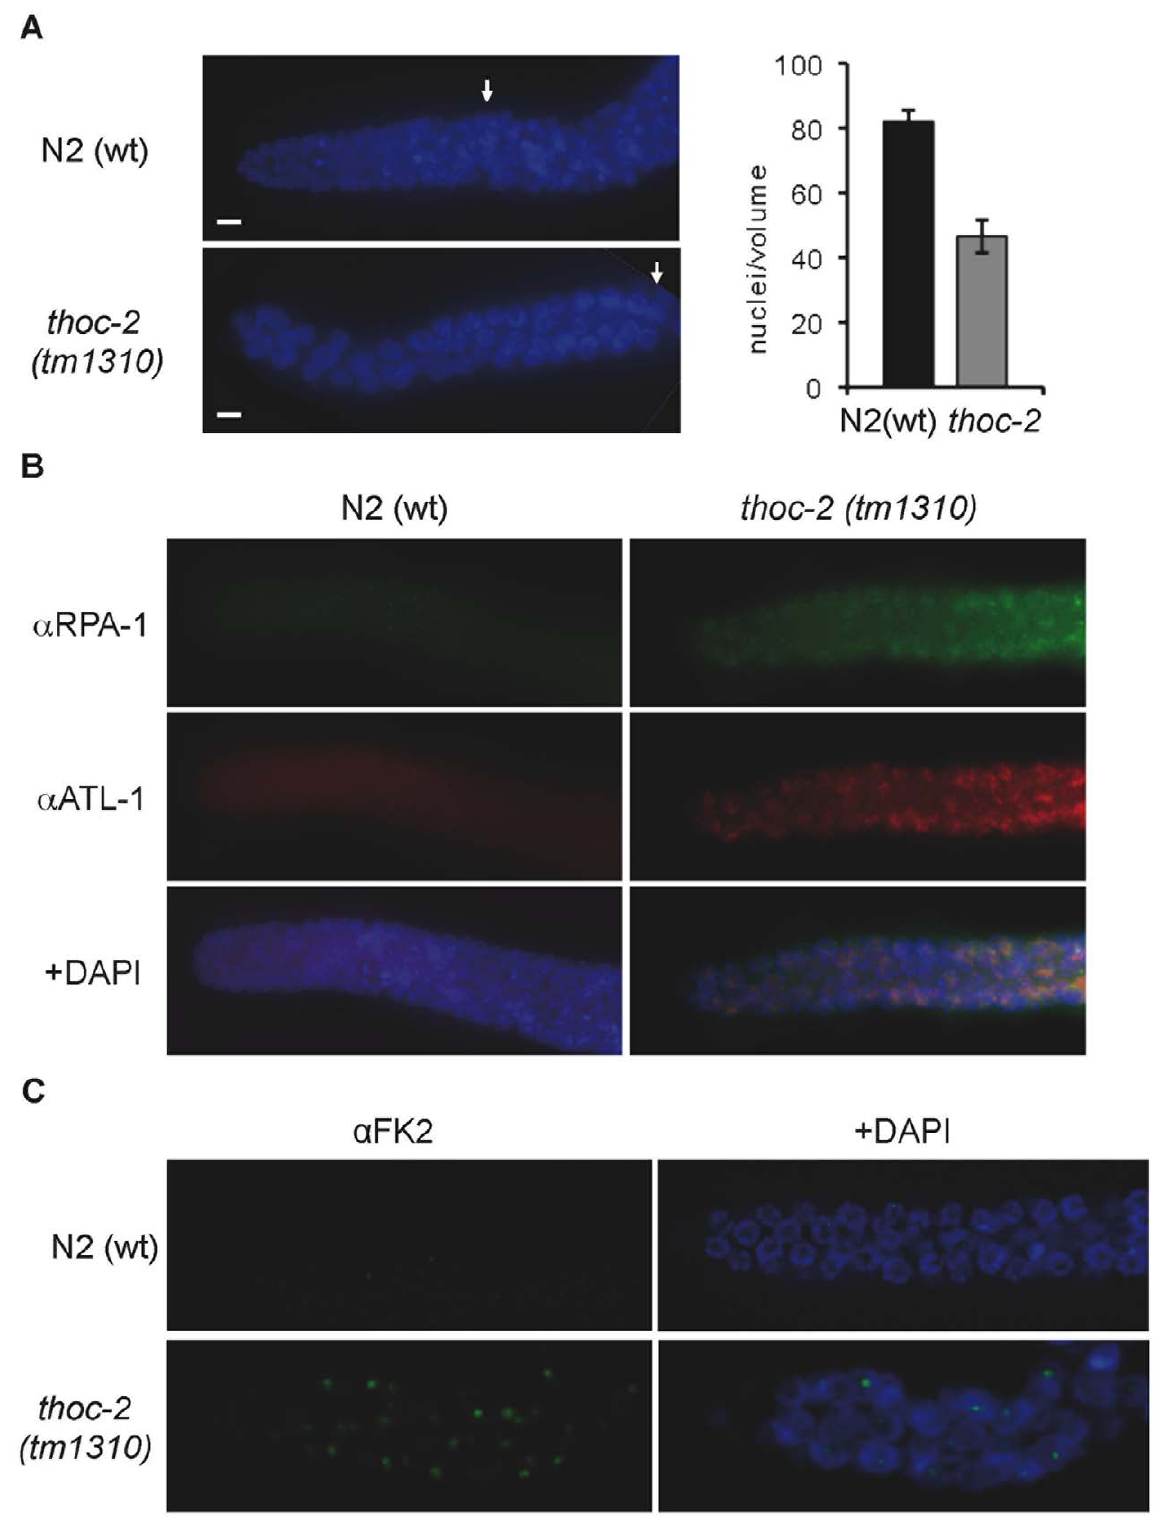
Figure 3. Mitotic DNA damage activation and replication impairment in thoc-2 mutants. ( A ) Representative images of a single focal plane through the mitotic region of the germline from N2(wt) and thoc-2(tm1310) counterstained with DAPI, and quantification of the number of mitotic nuclei. Error bars indicate standard errors of means (n=20). ( B ) Representative images of fixed mitotic nuclei from animals of the indicated genotype immunostained with antibodies against the replication protein RPA and the checkpoint kinase ATL-1. ( C ) Representative images of fixed mitotic nuclei from animals of the indicated genotype immunostained with FK-2.